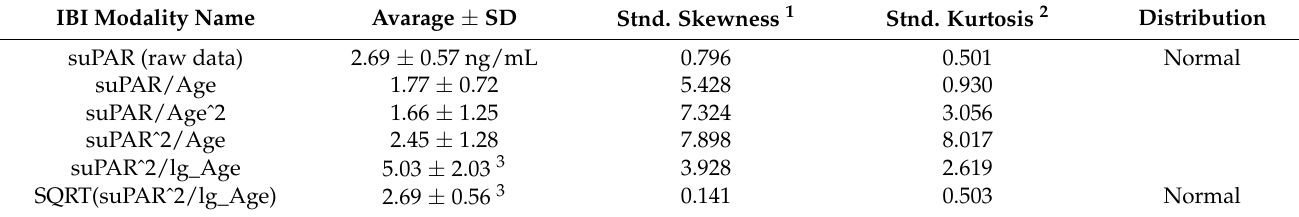
Table 1. Index of body inflammation calculated in five investigated ways. Summary view for distribution and age dependency.